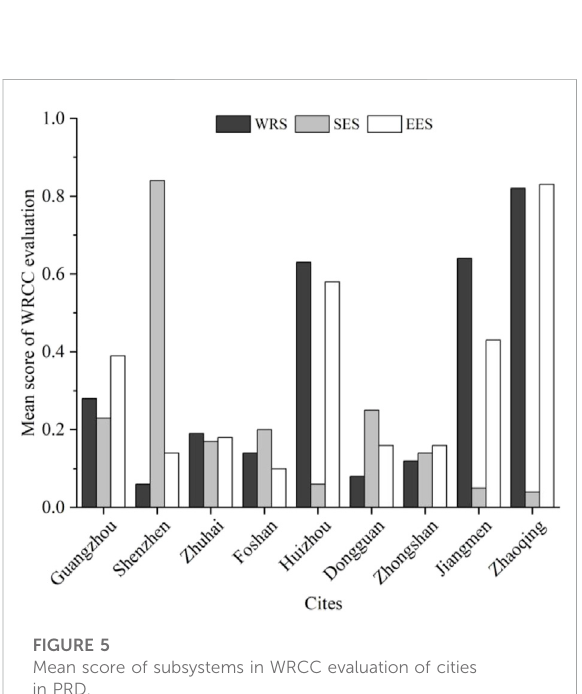
FIGURE 5 Mean score of subsystems in WRCC evaluation of cities in